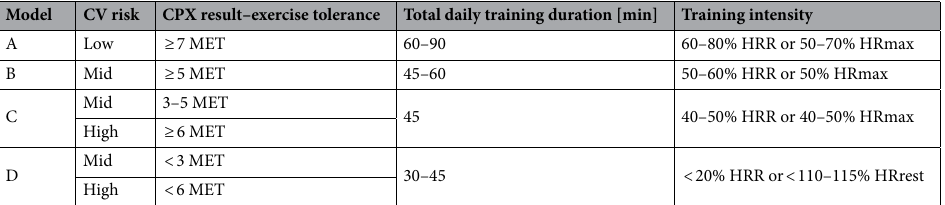
Table 1. Models of main cardiac rehabilitation training according to Polish Cardiac Society guidelines 4 . CPX: cardiac stress test; CV: cardiovascular; HRmax: maximum heart rate during CPX; HRrest: resting heart rate; HRR: heart rate reserve; MET: metabolic equivalent of task; min: minutes; HRR = maximum heart rate during CPX – resting heart rate 4 .